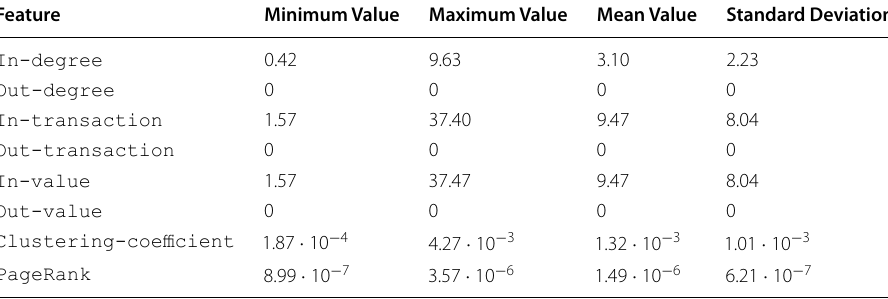
Table 6 Minimum, maximum, mean and standard deviation of the values of the spectrum features for the class